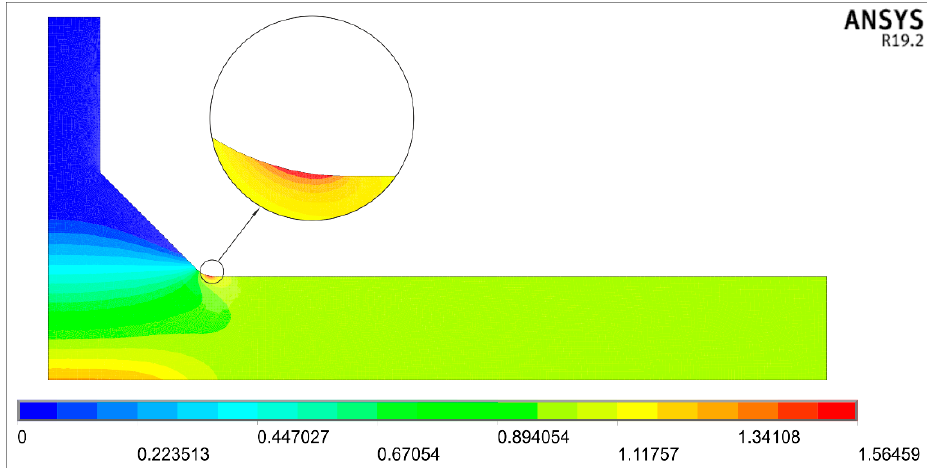
Figure 3. Example of a finite element mesh for θ = 45°, while X = 0.25, Y = 0.415, and T / t = 1.